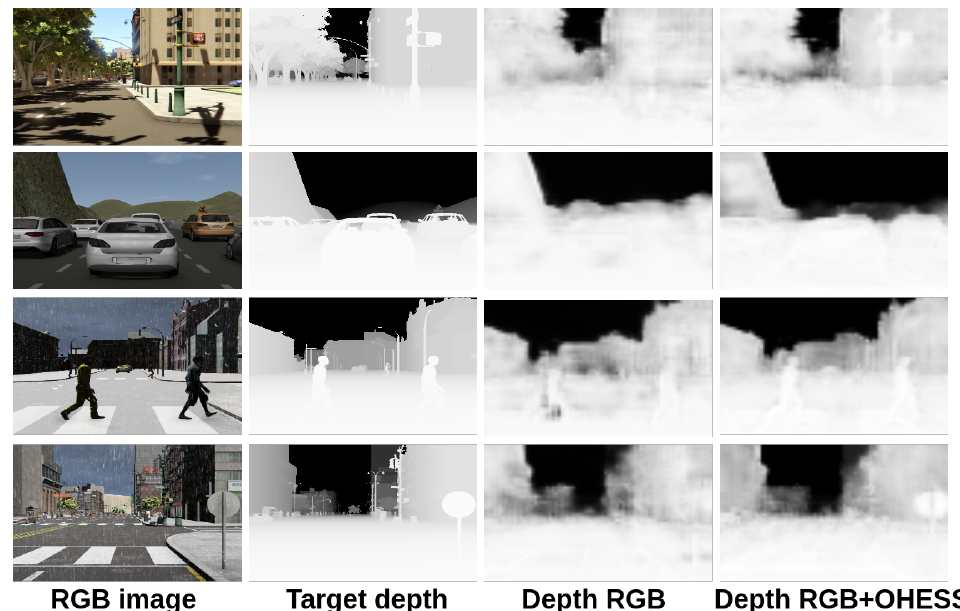
Figure 12. Results obtained with the SCRX CNN